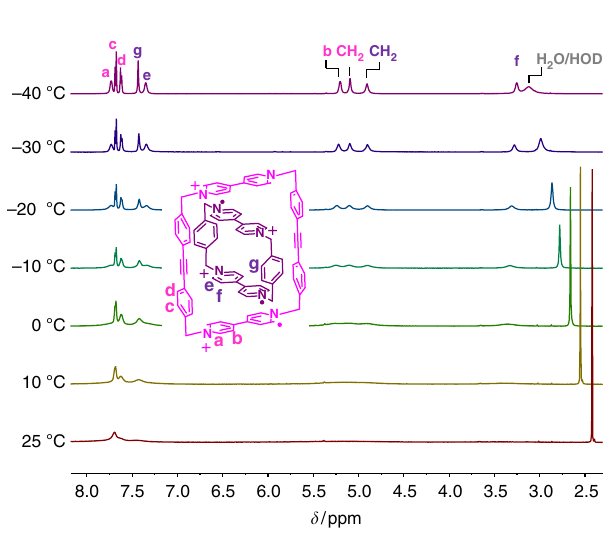
Fig. 4 VT-NMR studies of [ CBPQT ⊂ 1 ] 4( + (cid:129) ) . 1 H NMR Spectra recorded from − 40 to + 25 °C for a 1:1 molar mixture of CBPQT 2( + (cid:129) ) and 1 2( (cid:129) + ) (1.0 mM each) in CD 3